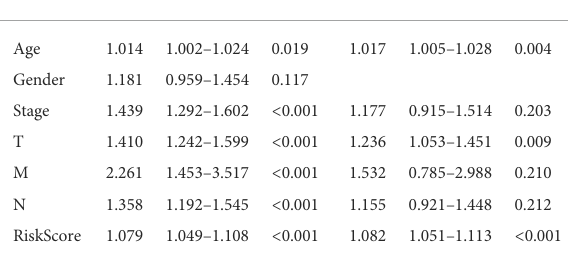
Figure 9A, genes associated with tumor-promoting effects were mostly downregulated in the high-risk group and upregulated in the low-risk group.